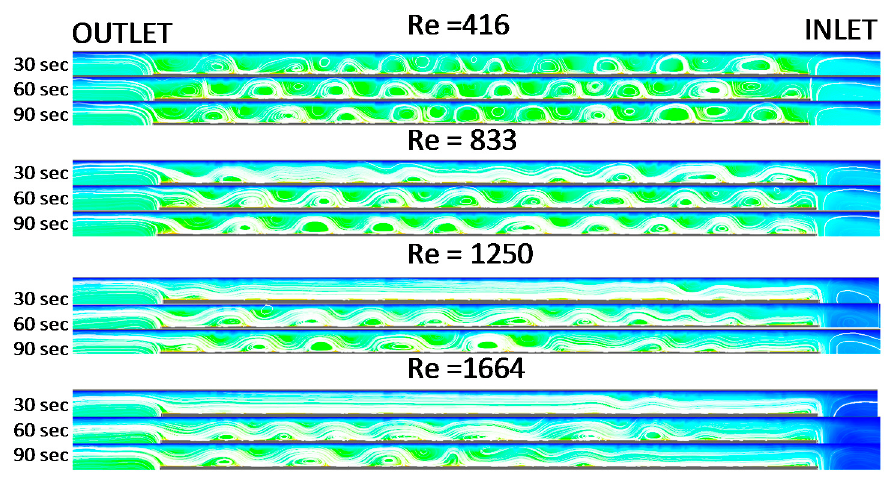
Figure 19. CFD velocity streamlines versus inlet air supply mass flow rates for fixed rotation of Ta = 3867.